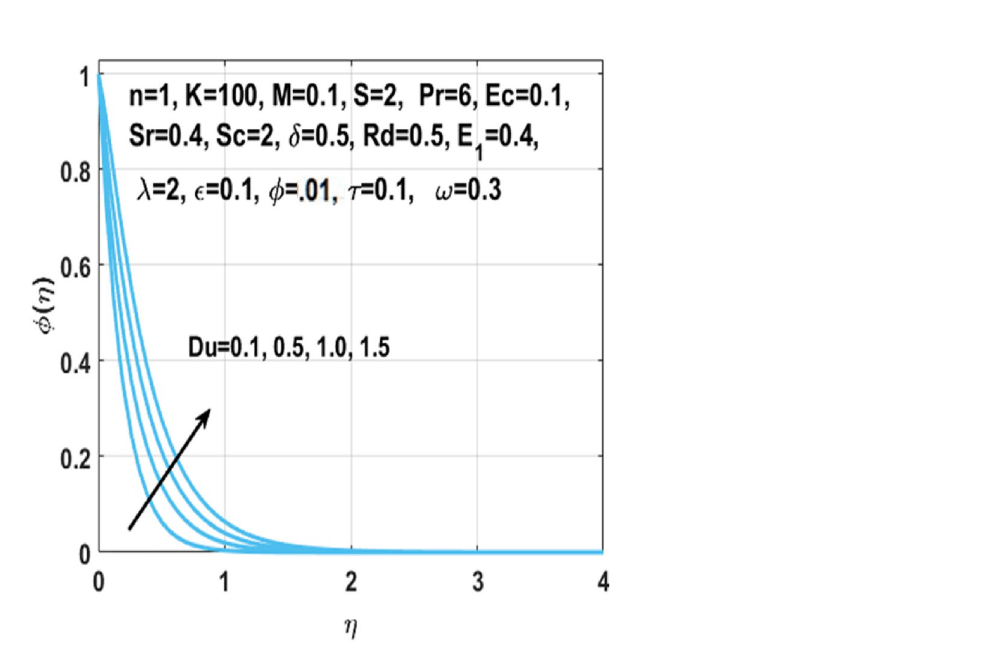
Figure 9. Impact of Du on φ(η)